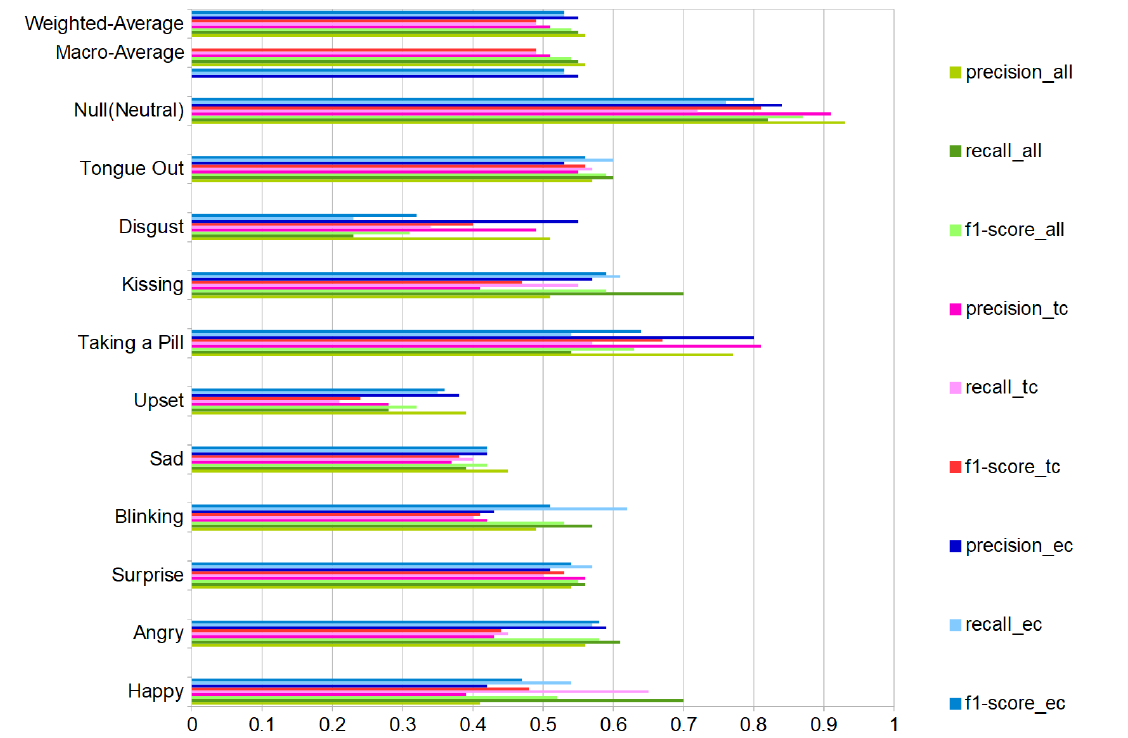
Figure 15. Classification results (Support Vector Machine) all volunteers for all DMAs (green bars), only temples-cheeks (red bars) and eyebrows-cheeks (blue bars). Ten activities and the null-class, with precision, recall and f1-score. Results with total test-events = 880 (80 per class, counting